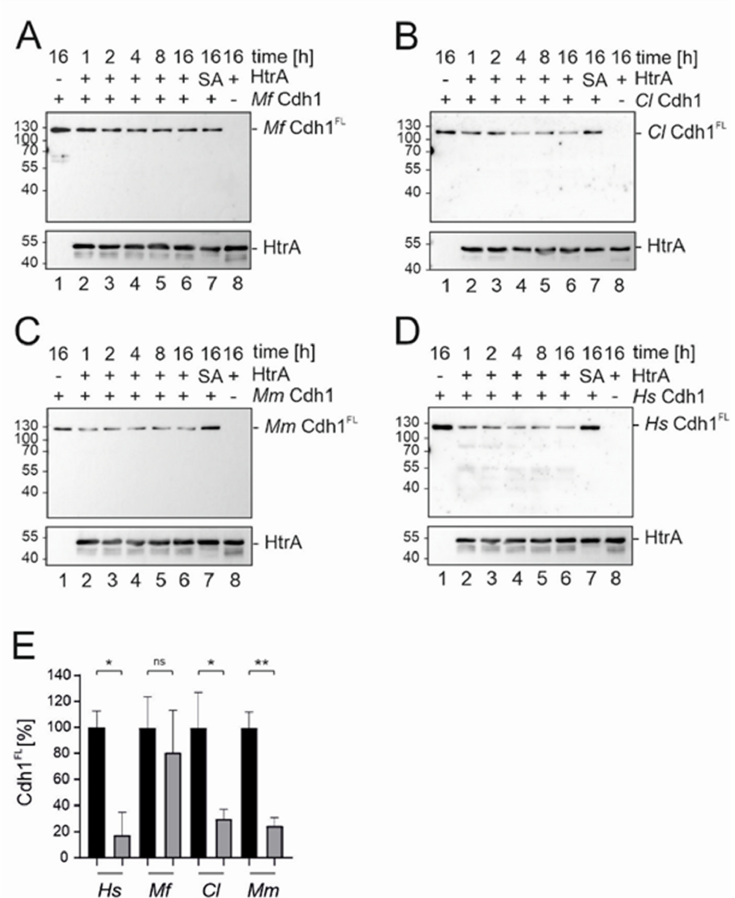
Figure 3. Kinetics of HtrA-mediated Cdh1 cleavage. 100 ng of recombinant Mf Cdh1 ( A ), Cl Cdh1 ( B ), Mm Cdh1 ( C ), and Hs Cdh1 ( D ) were incubated with 250 ng recombinant active HtrA for the indicated time points at 37 °C (lanes 2–6). As a control, recombinant Cdh1 was incubated for 16 h with inactive HtrA (SA, lane 7) or left untreated (lane 1). To control antibody cross-reactions, HtrA alone was loaded (lane 8). The different Cdh1 FL variants were detected using an antibody recognizing the C-terminal His 6 -tag. HtrA was detected using a polyclonal HtrA antibody. ( E ) The amount of Cdh1 FL treated for 16 h with recombinant active HtrA (grey) or inactive HtrA SA (black) was quantified by blot densitometry. Data are presented as percent means of Cad FL ± SD ( n = 3), with the cadherin treated with the inactive HtrA SA set at 100% and compared with the signal intensity of Cdh1 FL treated with active HtrA for 16 h. Asterisks indicate statistically significant differences (** p < 0.01; * p < 0.05; ns, not significant).